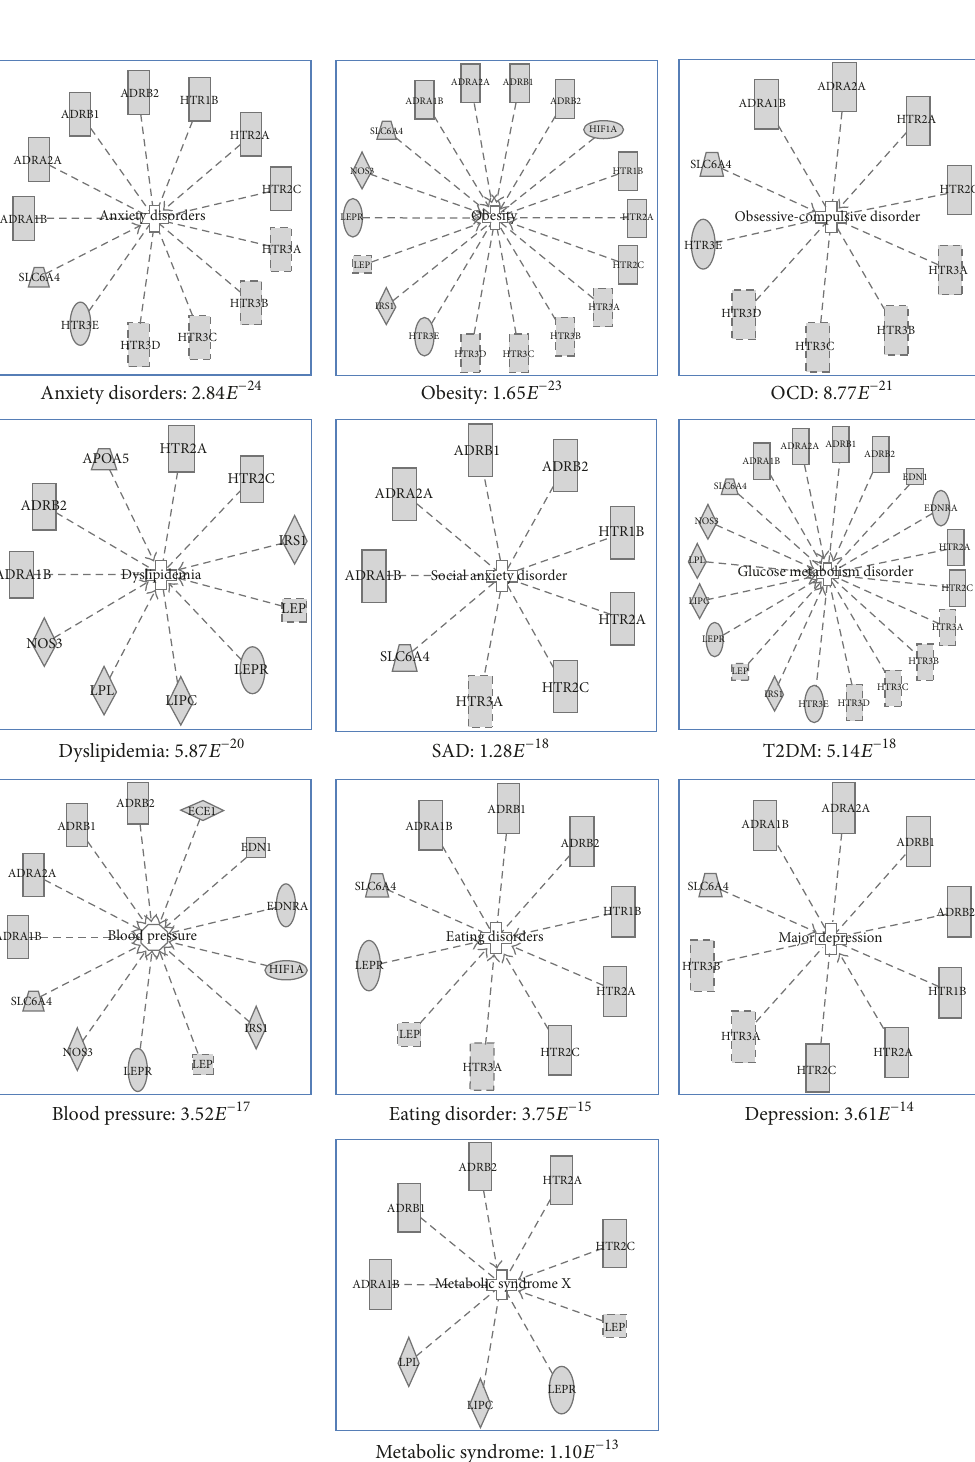
Figure 2: The genes identified from the enrichment analysis were significantly associated with OSA comorbidities. Ingenuity Pathway Analysis was used to create gene-disease network. The selected candidate genes ( 𝑛 = 23 ) were significantly associated with anxiety disorders ( 2.8𝐸 −24 ), obesity ( 1.65𝐸 −23 ), obsessive-compulsive disorder ( 8.77𝐸 −21 ), dyslipidemia ( 5.87𝐸 −20 ), social anxiety disorder ( 1.28𝐸 −18 ), type 2 diabetes ( 5.14𝐸 −18 ), blood pressure ( 3.25𝐸 −17 ), eating disorder ( 3.75𝐸 −15 ), depression ( 3.61𝐸 −14 ), and metabolic syndrome ( 1.10𝐸 −13